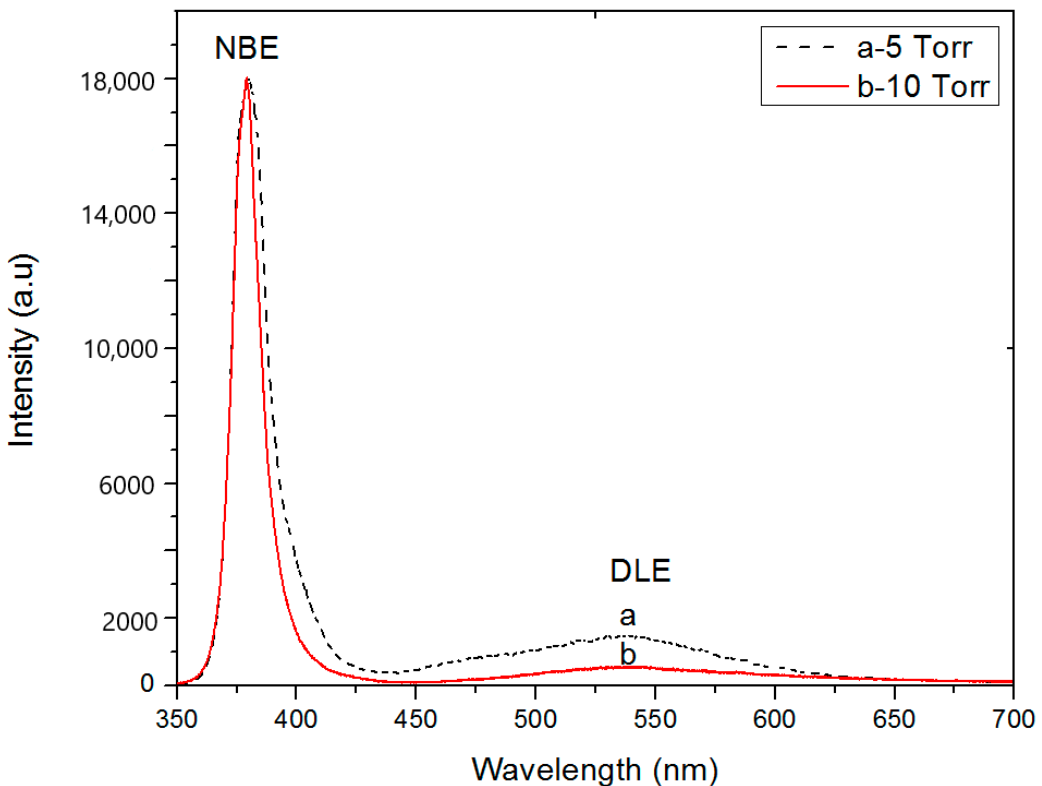
Figure 10. Room-Temperature photoluminescence (RT–PL) spectra of ZnO NWs grown at 5 Torr (dashed line) and 10 Torr (solid line) argon environment. NBE is the near-band edge emission and the defect level emission is DLE. Table 2. Intensity ratio UV/visible of ZnO NWs deposited at 5 Torr and 10 Torr, respectively.